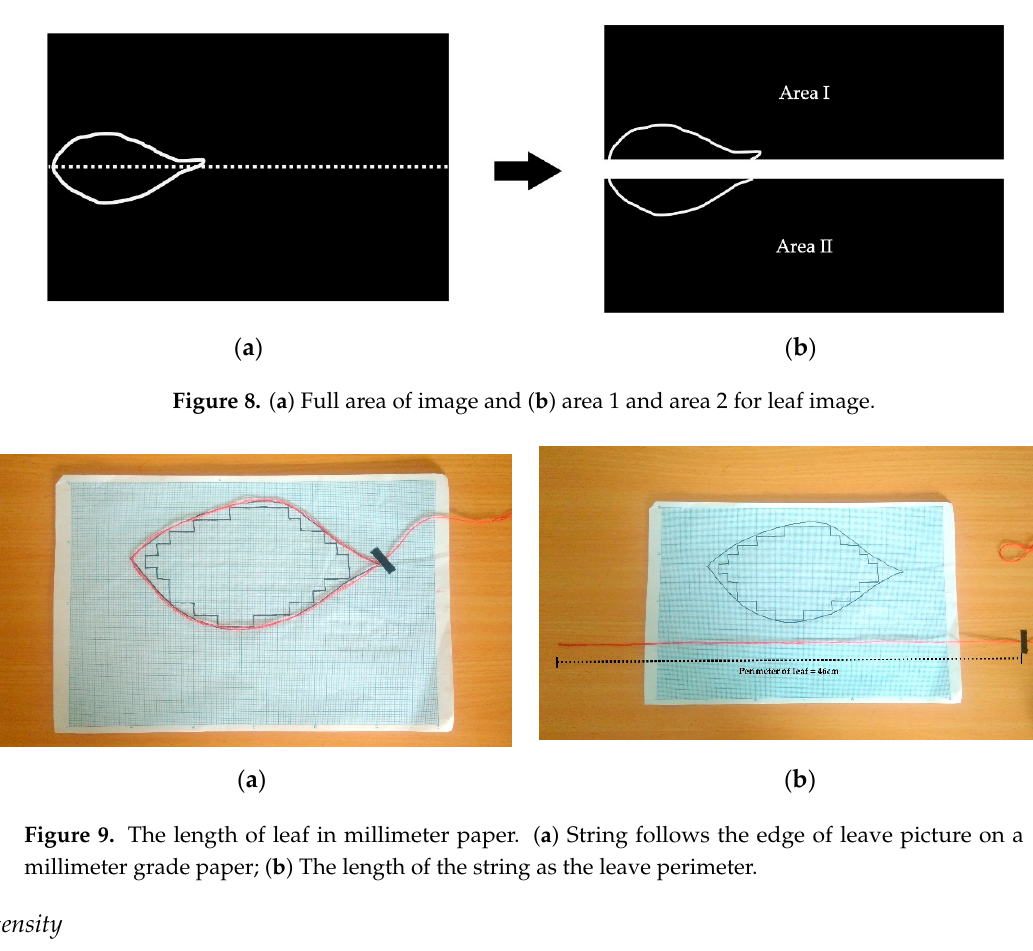
Figure 9. The length of leaf in millimeter paper. ( a ) String follows the edge of leave picture on a millimeter grade paper; ( b ) The length of the string as the leave perimeter.